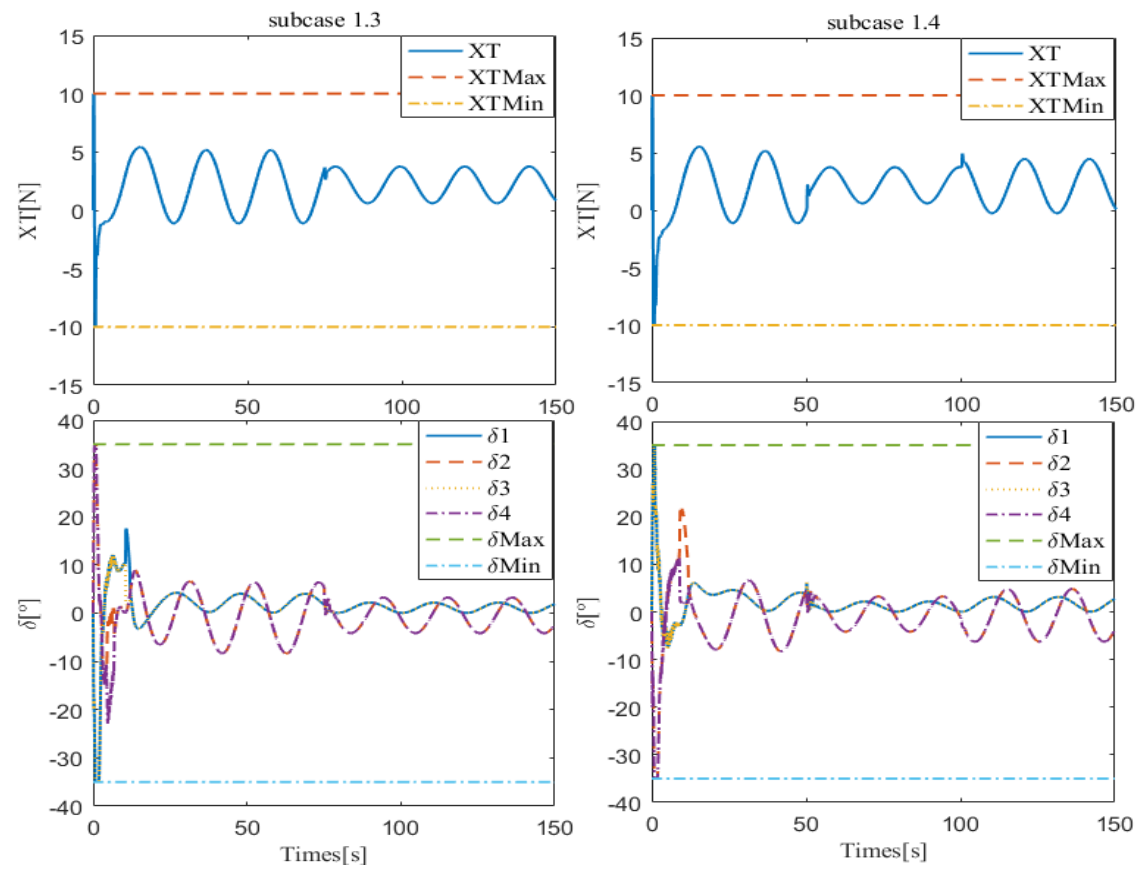
Figure 8. Control inputs of subcases 1.3 and 1.4.